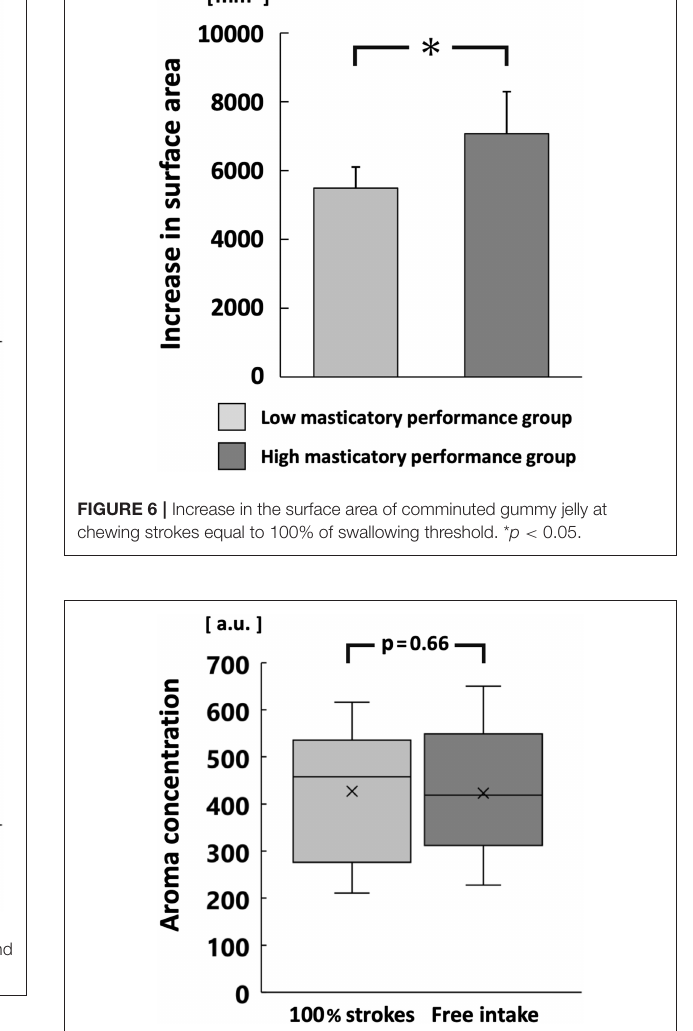
area ( r = 0.55; p < 0.01; Figure 9 ). No significant correlation